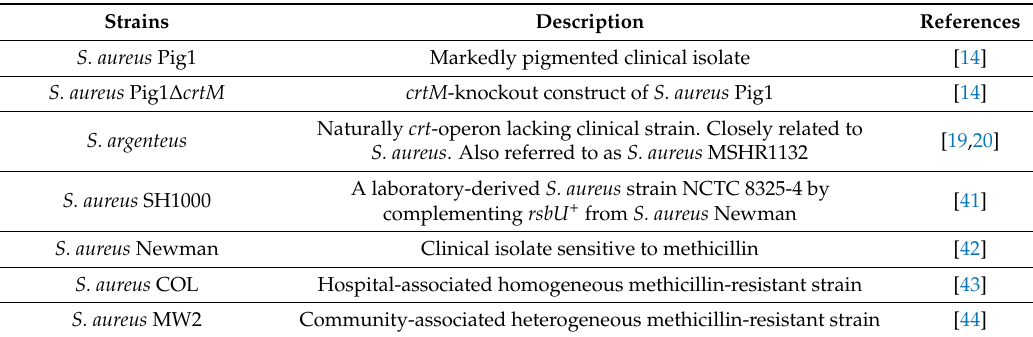
Table 9. Description of the strains used in this